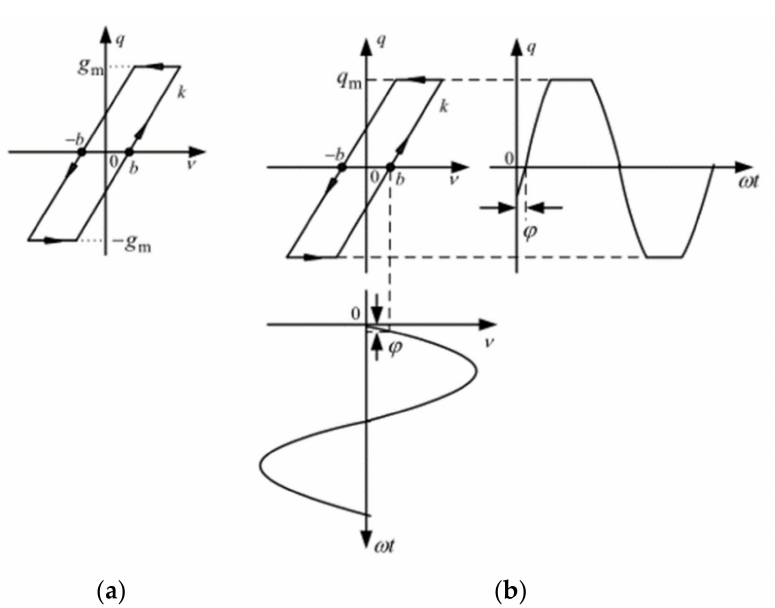
Figure 6. The nonlinear characteristics and influence on output signals with gear clearance. ( a ) Gear clearance nonlinear characteristics; ( b ) Influence of gear clearance on the output signal.